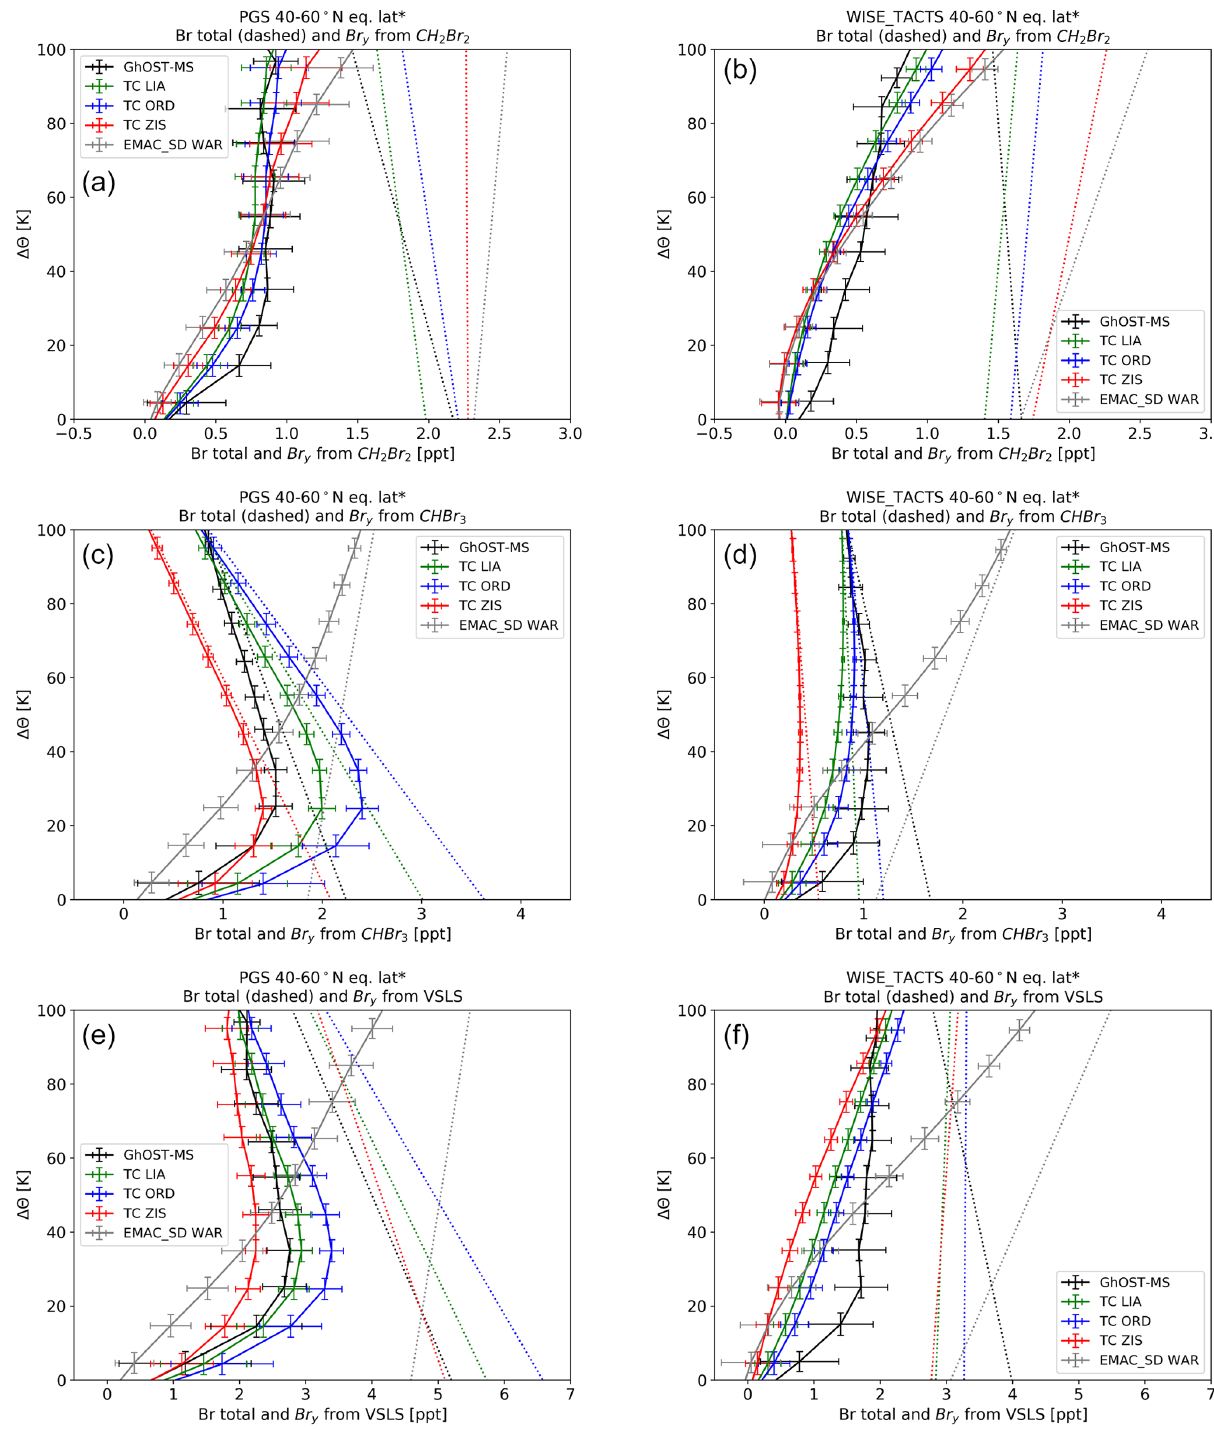
Figure 14. Vertical profiles of Br y (solid lines) and total bromine (dotted lines) from CH 2 Br 2 , CHBr 3 and total organic VSLS bromine averaged over 40–60 ◦ of equivalent latitude ∗ for the winter PGS campaign ( a, c, e , late December 2015 to March 2016) and the period form late summer to early fall ( b, d, f , WISE and TACTS campaigns) in comparison to model results from the TOMCAT and the EMAC model using different emission scenarios (see text for details on calculation of Br y ). Total bromine is calculated from data at the tropical and extratropical tropopause and using assumptions about fractional input from these two source regions (see text for details). The data are displayed as a function of potential temperature above the tropopause. In the case when no model information on the tropopause altitude was available (TOMCAT), climatological tropopause values have been used (see text for